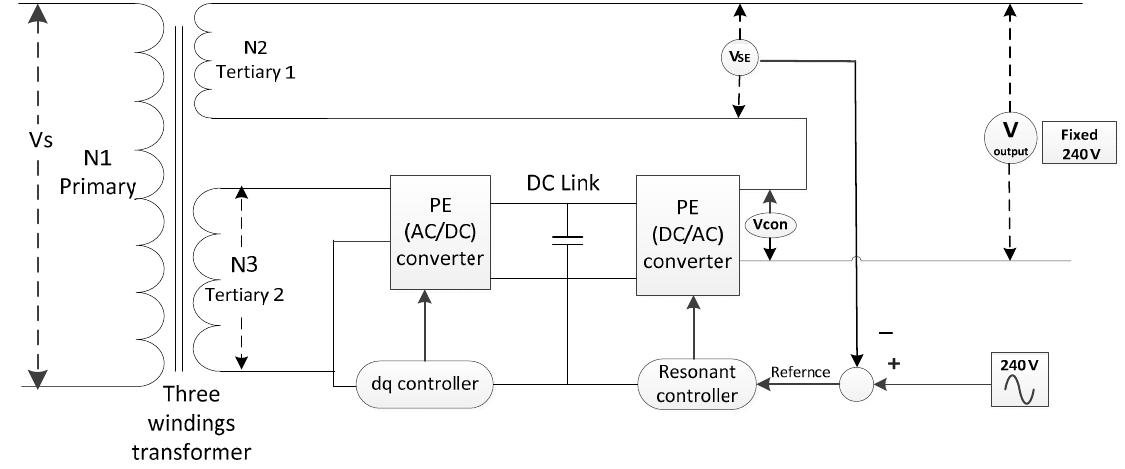
Figure 7. A schematic diagram of the overall control of the output voltage.